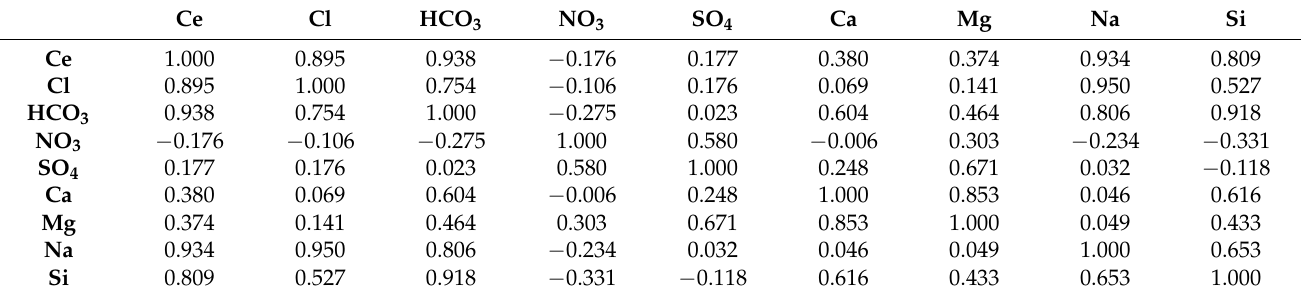
Table 2. Correlation matrix of mayor elements. Coefficients higher that 0.75 are highlighted in